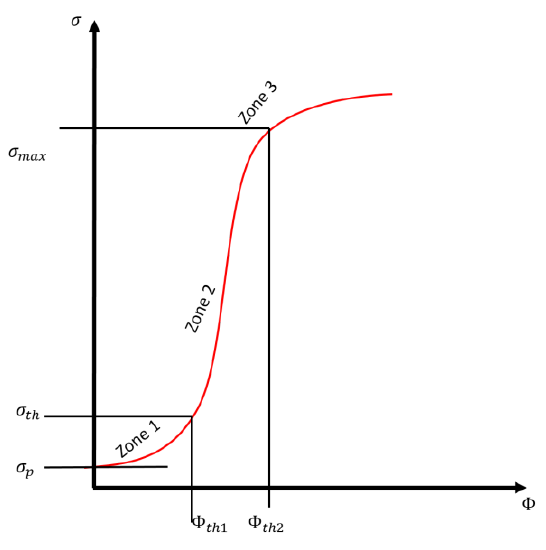
Figure 1. S -like percolation curve of the polymer composite electrical conductivity, where σ p is the conductivity of the polymer, σ th is the conductivity at the percolation threshold, and ϕ th1 and ϕ th2 are the lower and upper volume fractions, respectively.